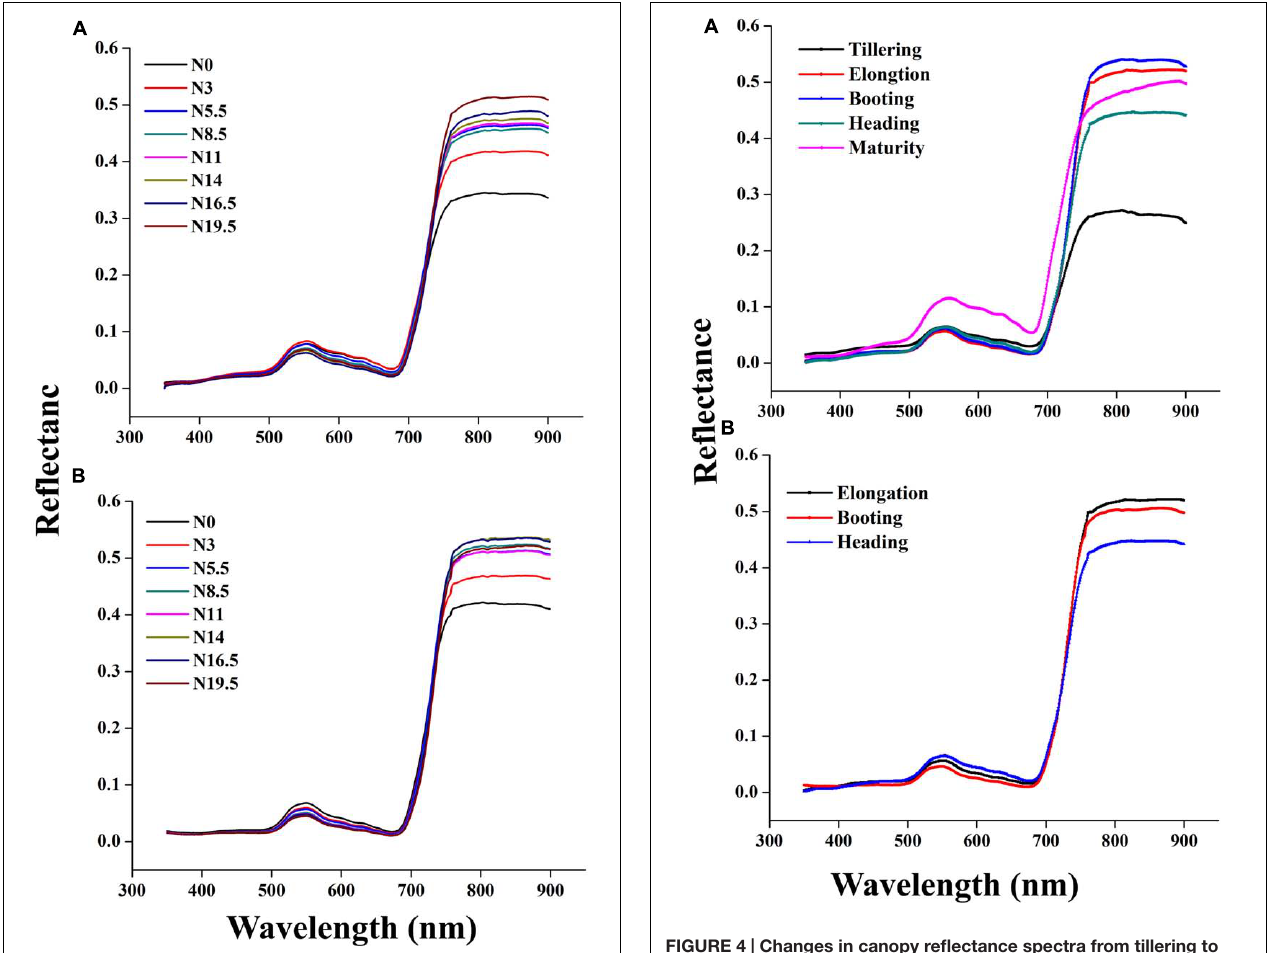
FIGURE 4 | Changes in canopy reflectance spectra from tillering to maturity of rice in 2015 (A) elongation, booting, and heading stages in 2016 (B) under different N